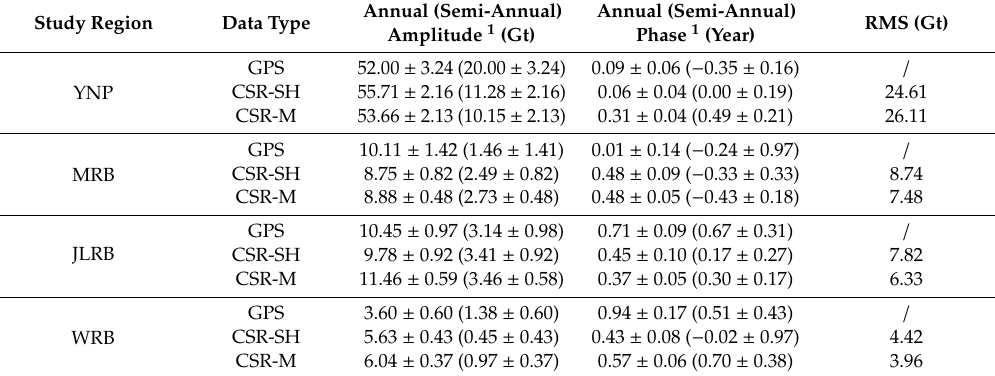
Table 2. Statistics of amplitudes and phases of annual and semi-annual surface mass change time series for the four studied regions, the Yunnan Province (YNP), Min River Basin (MRB), Jialing River Basin (JLRB), and Wu River Basin (WRB), based on GPS and GRACE inversion results from January 2011 to June 2017, and the Root Mean Square (RMS) di ff erences of the mass change time series between GPS and CSR GRACE-SH, GPS and CSR GRACE-M, respectively. The abbreviations of CSR-SH and CSR-M in the table represent CSR GRACE-SH and CSR GRACE-M,